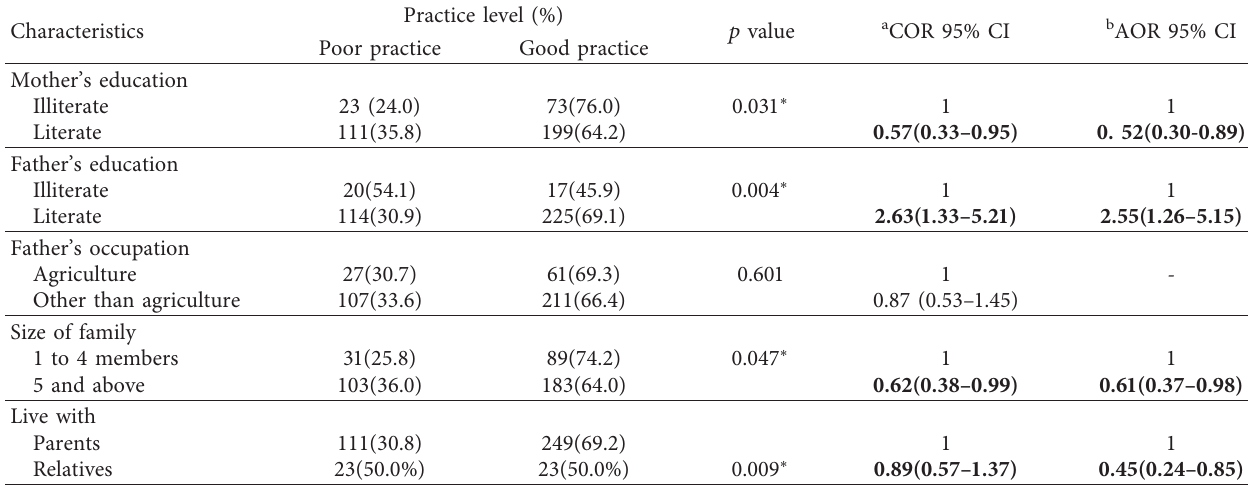
Table 3: Factors associated with level of practice in using bivariate and multivariate